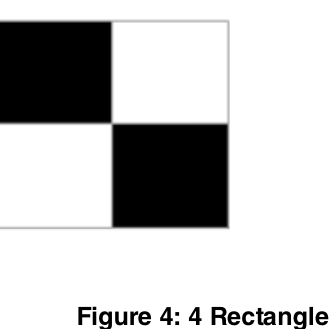
Figure 4: 4 Rectangle